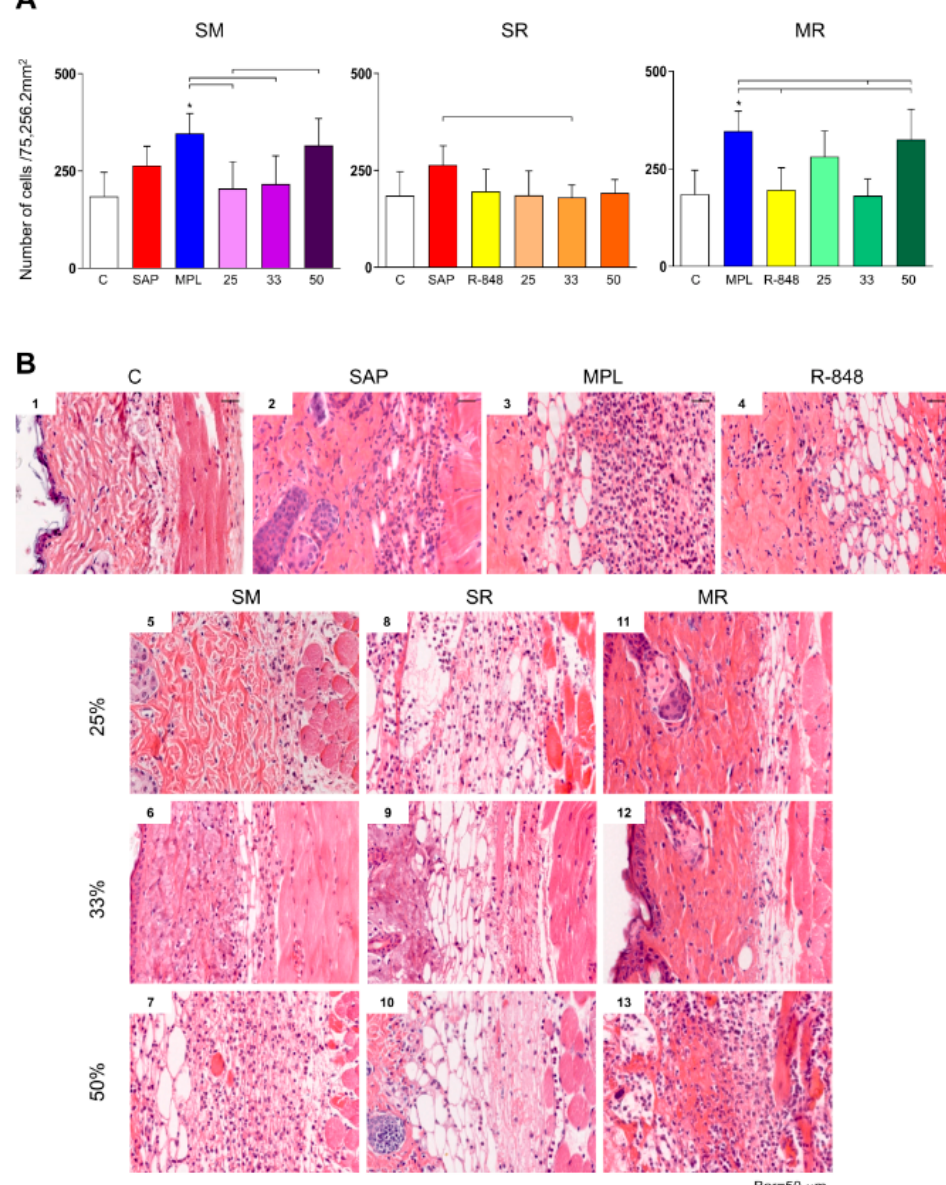
Figure 1. Inflammatory cells infiltrate evaluation in the BALB/c mouse skin 48 h after sensitization with the adjuvants isolated or combined into adjuvant systems ( n = 12/group). ( A ) Inflammatory cells infiltrating in the dermis/epidermis were expressed by the number of cells per 75,256.2 mm 2 . The data analyses were performed by one-way Anova followed by Tukey’s multiple comparison test and expressed as absolute values ± SD. The significant differences are indicated by connector lines for comparison between the groups ( p -value < 0.05) and by (*) for comparison with the control group (C). ( B ) Representative photomicrographs of the inflammatory cells infiltrated in the BALB/c mouse skin 48 h after sensitization with the adjuvants isolated or combined into adjuvant systems. (1) Control group, (2) SAP, (3) MPL, (4) R-848, (5) SM25, (6) SM33, (7) SM50, (8) SR25, (9) SR33, (10) SR50, (11) MR25, (12) MR33, and (13) MR50. Slides shown at 40 × magnification. Hematoxylin–eosin. Bar = 50 μ m.